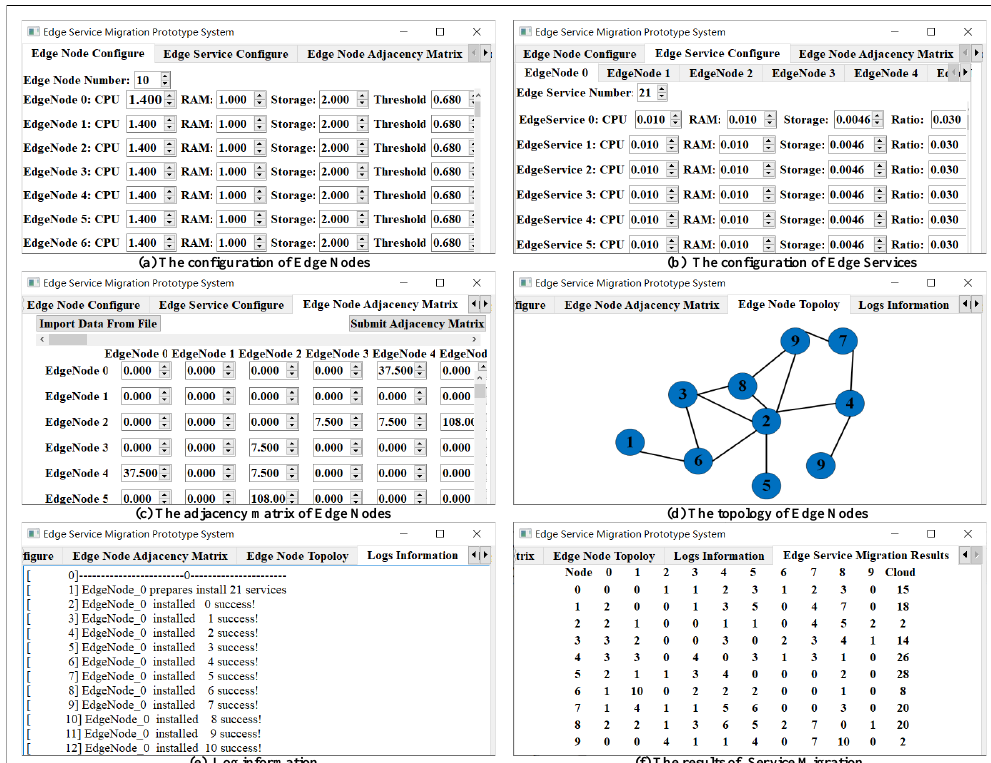
Figure 4. The user interface of the prototype